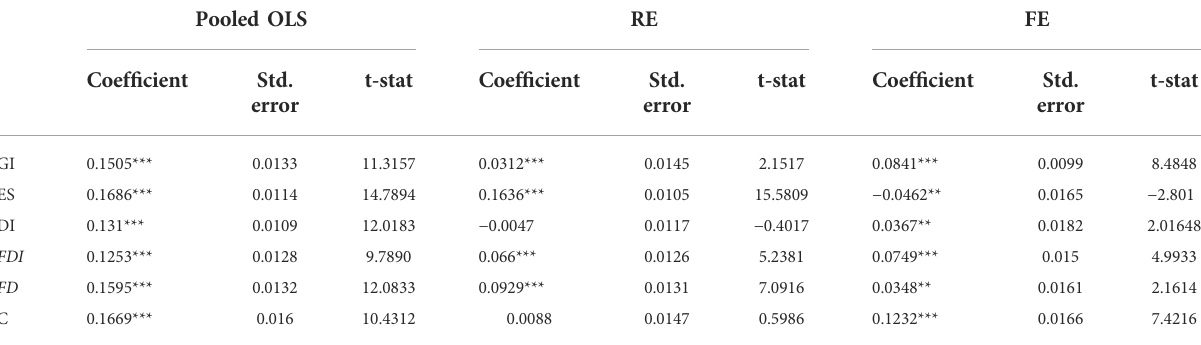
TABLE 5 Results of baseline estimation.